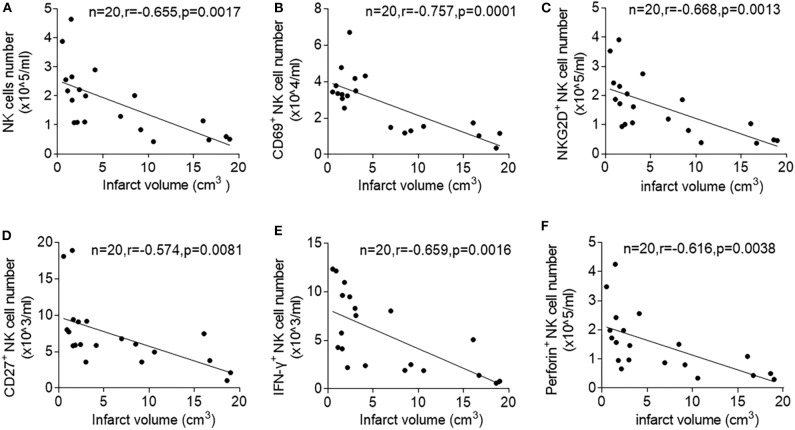
Correlation between infarct volume and circulating NK cell number and activity after ischemic stroke. Peripheral blood was obtained from patients with acute ischemic stroke during the acute stage (<3 days). Linear correlation between stroke volumes and numbers of peripheral NK cells (A), CD69+ NK cells (B), (NKG2D +NK cells (C), CD27+ NK cells (D), IFN-γ+ NK cells (E), and Perforin+ NK cells (F) in patients with ischemic stroke during acute phase of stroke. Data are presented as means ± SEM.